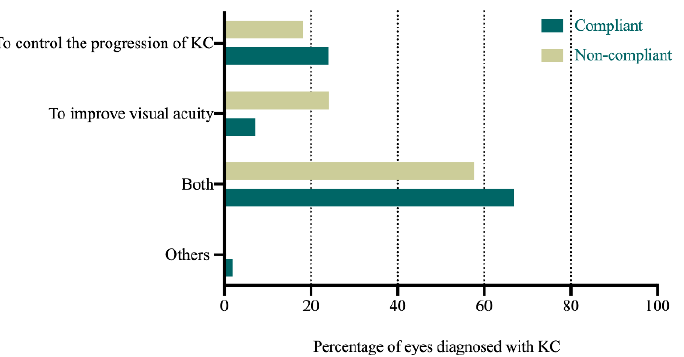
Figure 1. Comparison of the answers to the question “Why did you choose rigid gas-permeable contact lens?” between the compliant and non-compliant groups (KC, keratoconus).